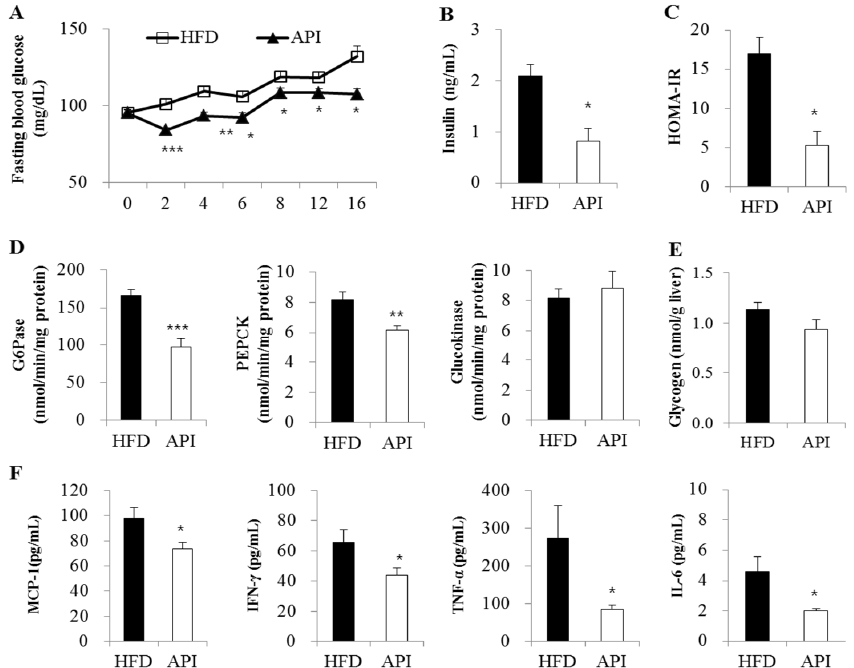
Figure 2. Effects of apigenin on ( A ) fasting blood glucose level; ( B ) plasma insulin level; ( C ) homeostatic index of insulin resistance (HOMO ‐ IR); ( D ) hepatic glucose metabolism ‐ related enzyme activities; ( E ) hepatic glycogen content and ( F ) plasma pro ‐ inflammatory marker levels in C57BL/6J mice fed a high ‐ fat diet. Data are shown as the means ± S.E. Values are significantly different between the high ‐ fat diet and apigenin groups according to Student’s t ‐ test: * p < 0.05; ** p < 0.01; *** p < 0.001. HFD: high ‐ fat diet (20% fat, 1% cholesterol); API: HFD + 0.005% apigenin.